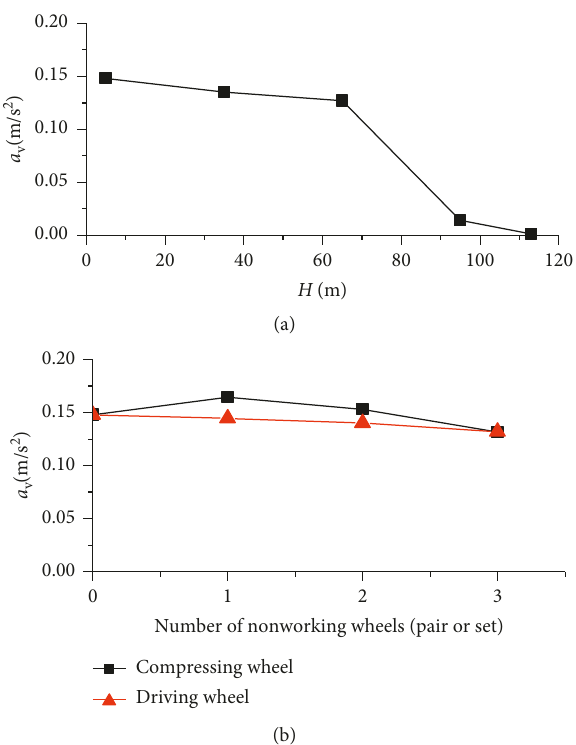
Figure 17: The variation curves of the a height and (b) the number of nonworking compressing/driving